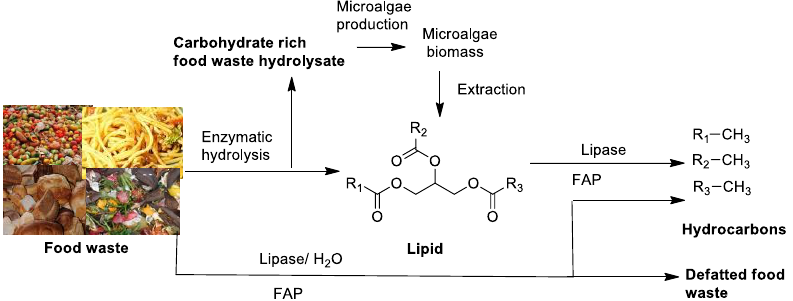
Figure 19. A proposed biocatalytic route for the valorization of lipid-rich food waste into hydrocar- bon-based fuels. bon-based